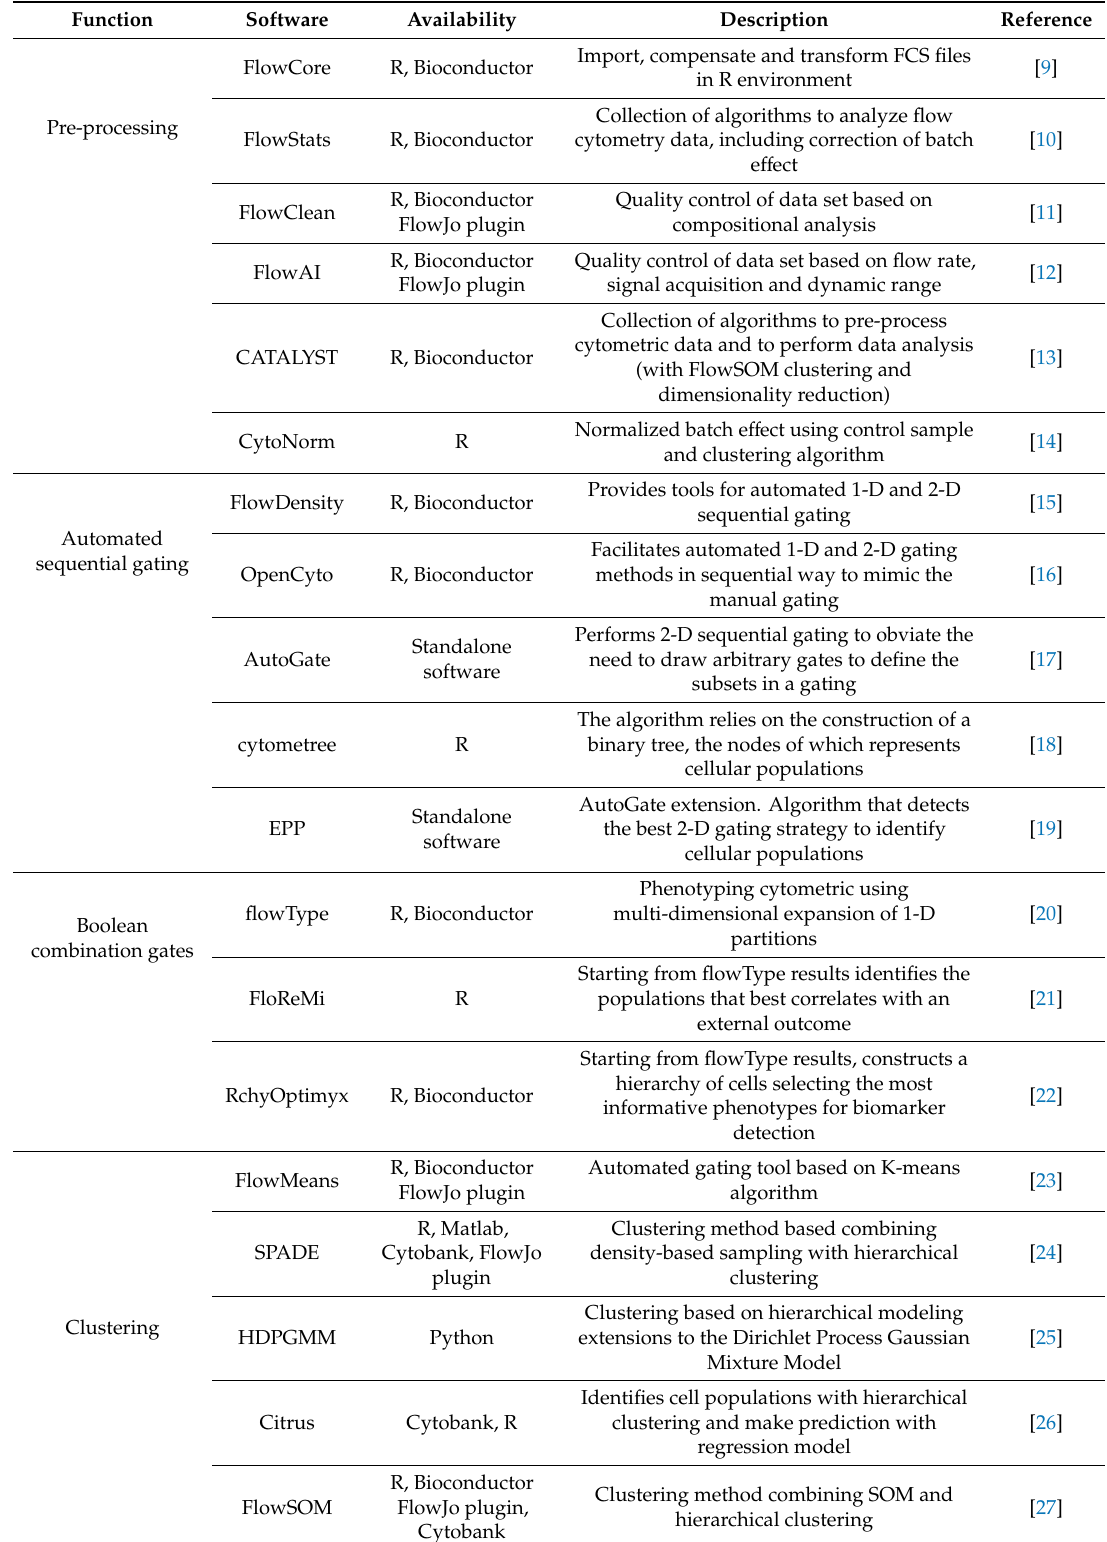
Table 1. Automated tools for the analysis of cytometric data. For each tool is reported the function, the statistical platform in which they are available, and a brief description of the main